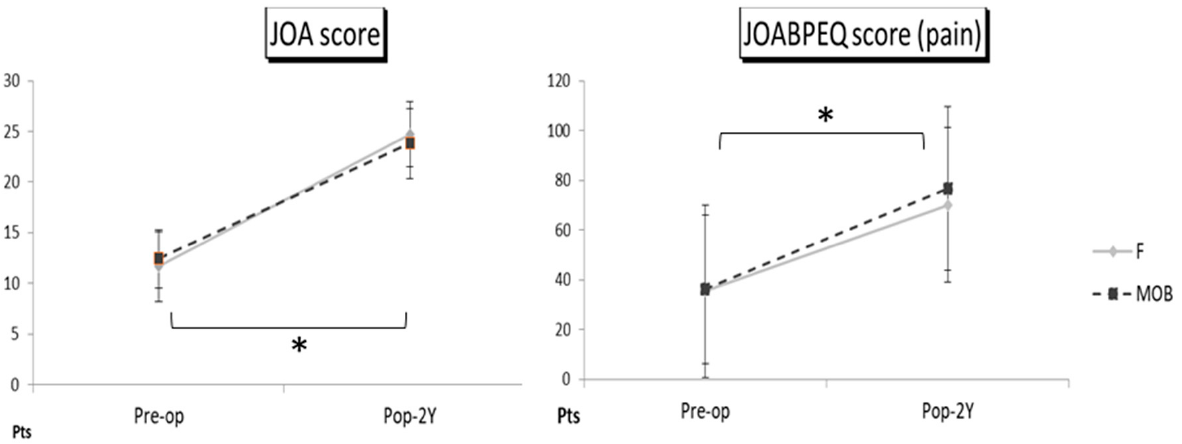
Figure 2. Sagittal vertebral axis (SVA) in the MOB patient group (MOB group) and the first surgical patient group (F group). The bars depict preoperative and follow-up average values and standard deviations in each group. Abbreviations: Pre-op, before surgery; Pop-2Y, at 2 years after surgery.